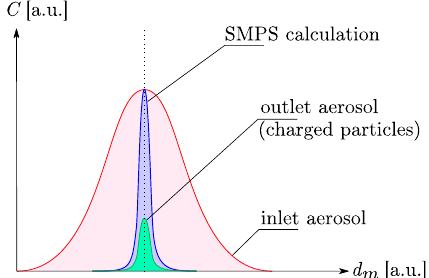
Figure 5. Illustration of the working principle of an aerosol classification by electrostatic technique. The blue area represents the concentration computed by the SMPS algorithm, based on the Boltzmann equilibrium. The effective aerosol (i.e., the particles sent to the sensor chamber) is the green area.